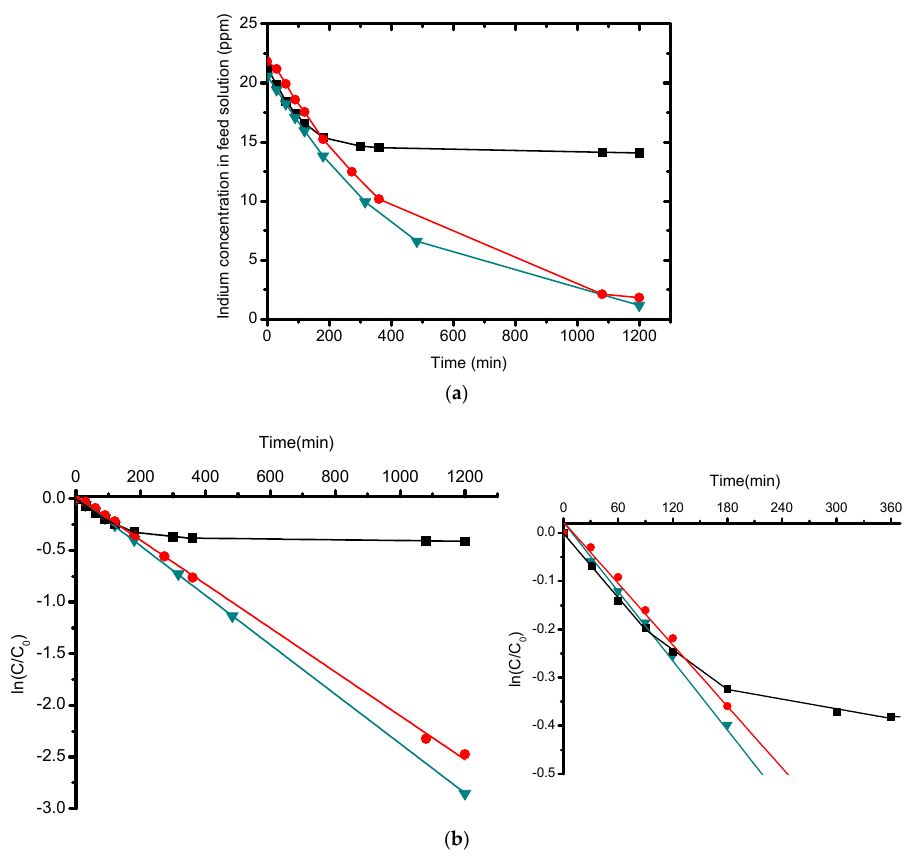
Figure 3. Time dependence of indium concentration in the feed solution for conventional PIM and PIMSD. ( b ) is the replot of the data of ( a ) in log scale, and the small figure in ( b ) is the magnification of the concentration change in the first 360 min. ▼ : conventional PIM with 1 M HCl as the strip solution; ￭ conventional PIM with 5 M HCl as the strip solution; ● : PIMSD with 5 M HCl as the strip solution.